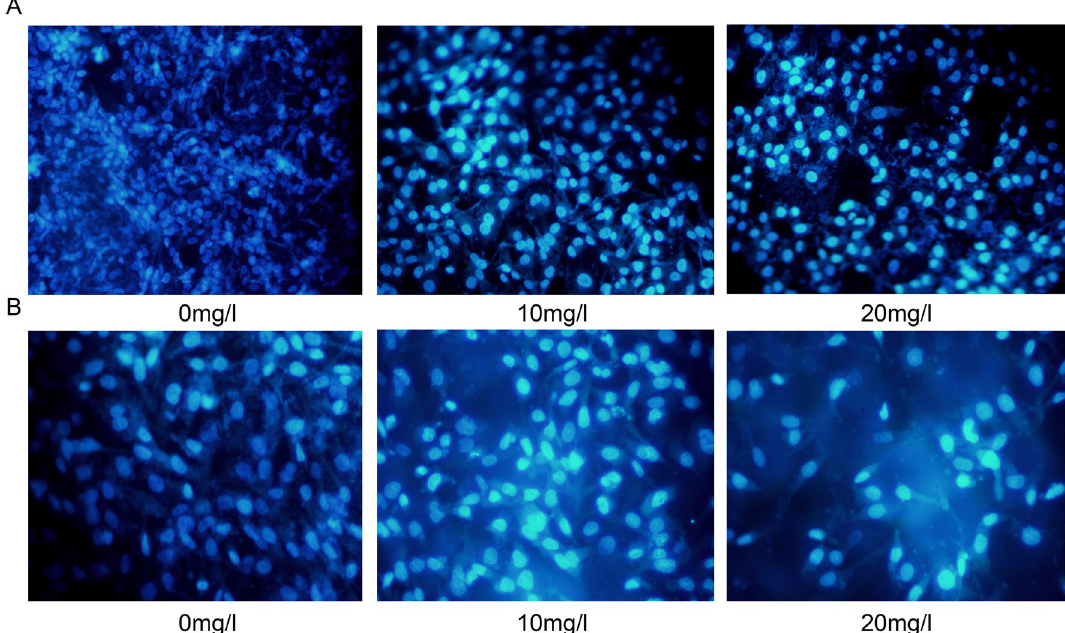
Figure 2. VALD-3 induces cell apoptosis in MCF-7 cells and MDA-MB-231 cells. Cells were treated without or with 10 mg/L, 20 mg/L VALD-3 for 48 h. Morphologic changes of MCF-7 cell ( A ) and MDA-MB-231 cells ( B ) VALD-3-treated were observed after Hoechst 33258